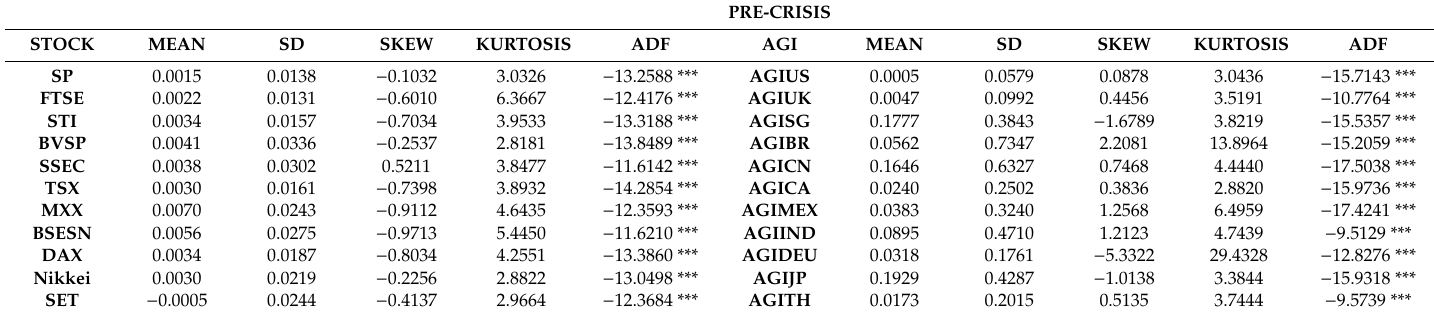
Table 2. Descriptive statistics for di ff erent